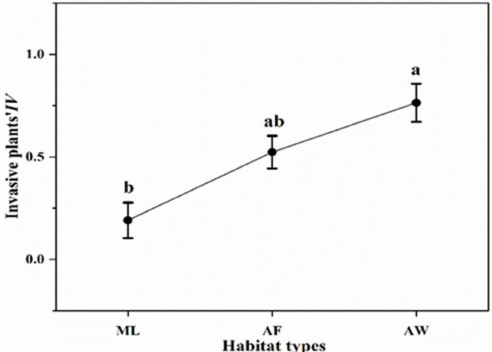
Figure 1. Important value (IV) of invasive plants in the communities of the three habitat types in Dianchi lakeside (note: different letters mean significant differences, p < 0.05; mean ±